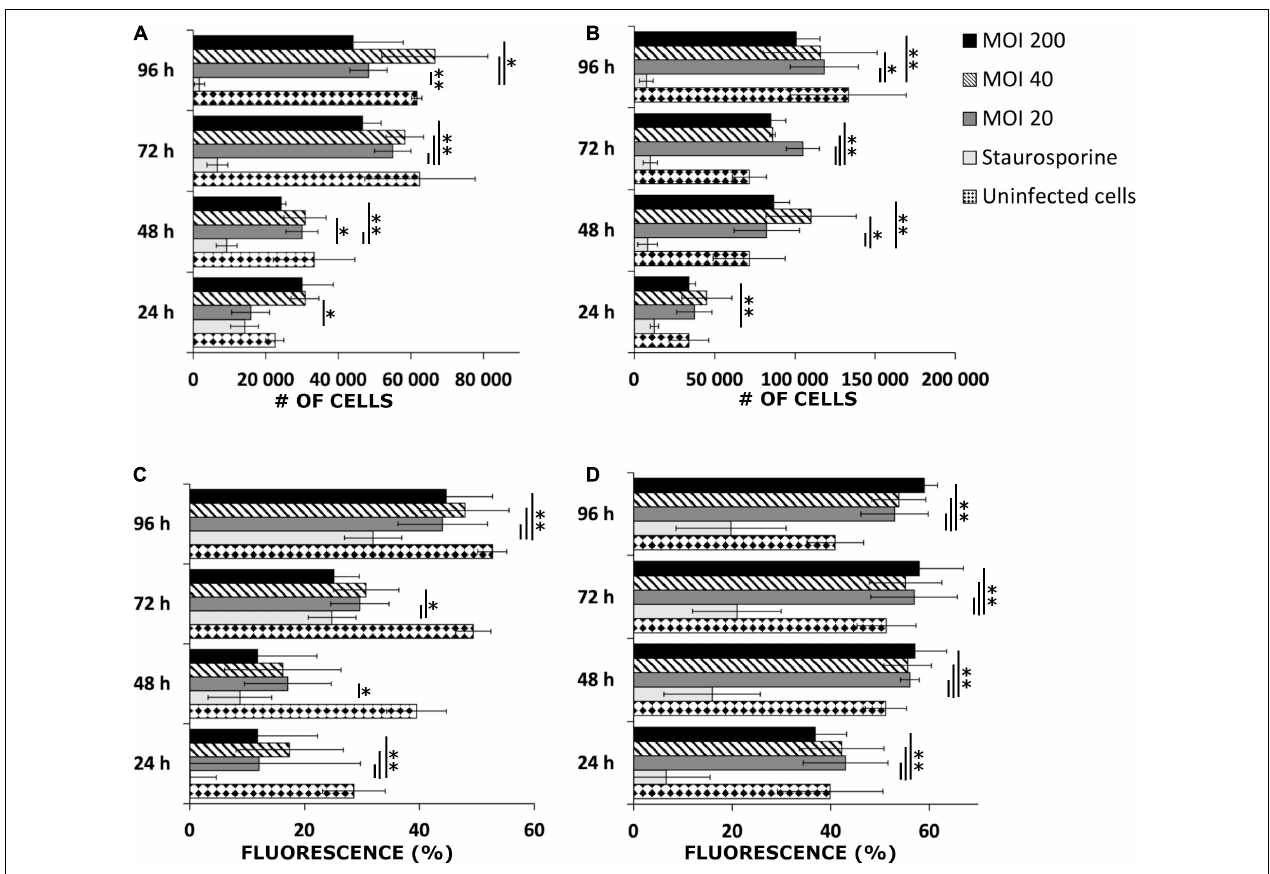
FIGURE 3 | Human cells remained viable after B. burgdorferi infection. Representative graphs of viable SW1353 (A) and BJ (B) cells infected with B. burgdorferi at four different time points and cells counted using Trypan Blue stain. Experiments were performed in triplicates and repeated three times. Uninfected cells were negative control, while staurosporine induced apoptotic cells were positive controls for death. MOIs 20, 40, and 200 were used. MitoTrackerTM Red CMXRos stain for live mitochondria was used to further verify the viability of the infected cells from three separate experiments. Flow cytometry was used to analyze the samples. A graphical illustration of the fluorescence signal in percentages (%) gathered from SW1353 (C) and BJ (D) cells, respectively. The same controls and MOIs were used as in the Trypan Blue experiments above. Error bars of standard deviations. Statistical significance was performed with Student’s t -test (* p ≤ 0.05; ** p ≤ 0.005).